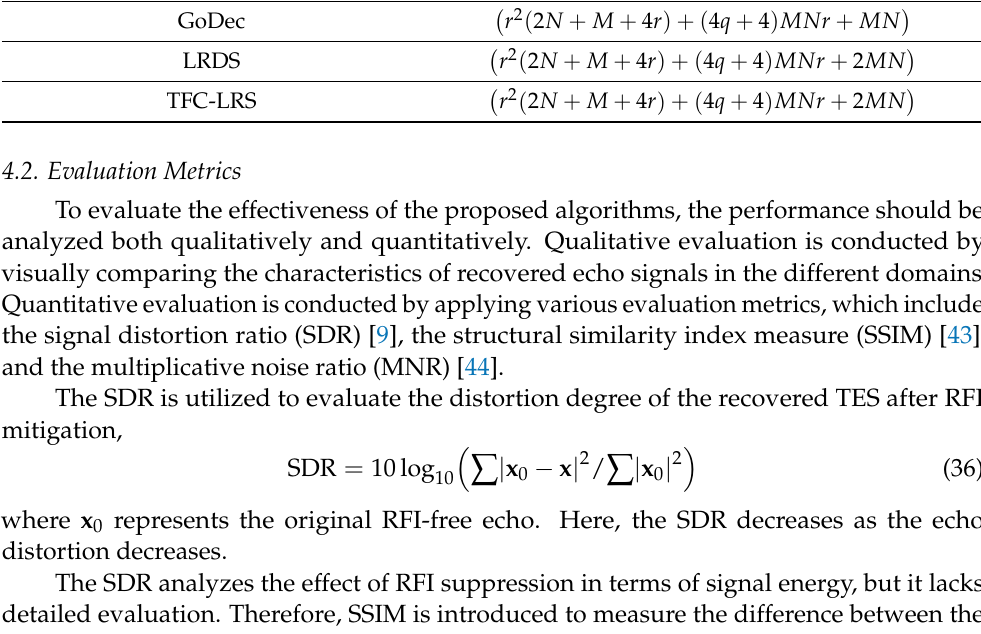
Table 2. Computational complexity of GoDec, LRDS, and TFC-LRS per iteration.